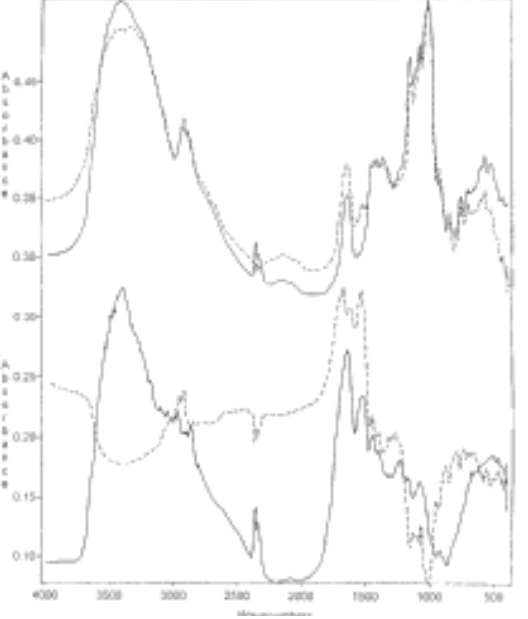
Figure 3. (1) Differential FTIR spectra of casein/PPWCS 1:2 complex from which (a) the spectrum of PPWCS was subtracted and (b) the spectrum of casein was added for comparison; (2) Differential spectrum of the same complex from which spectrum of casein was (a) subtracted and (b) the spectrum of PPWCS added for comparison.